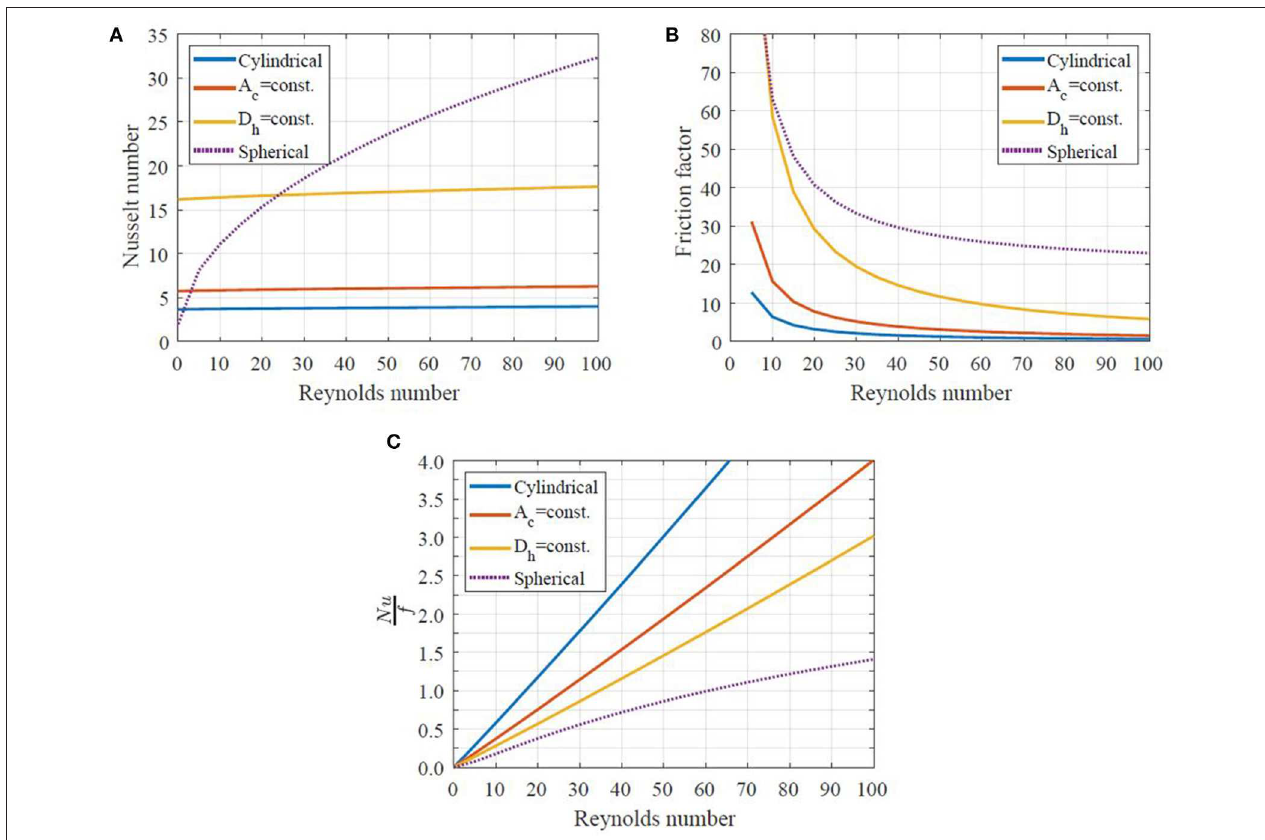
FIGURE 6 | (A) Nusselt number as a function of Reynolds number for all geometries modeled. (B) Friction factor as a function of Reynolds number. (C) Ratio of Nusselt number to friction factor as a function of Reynolds number for different geometries with porosity ε = 0.36, hydraulic diameter D h = 0.13mm, regenerator length with ordered flow structures l =